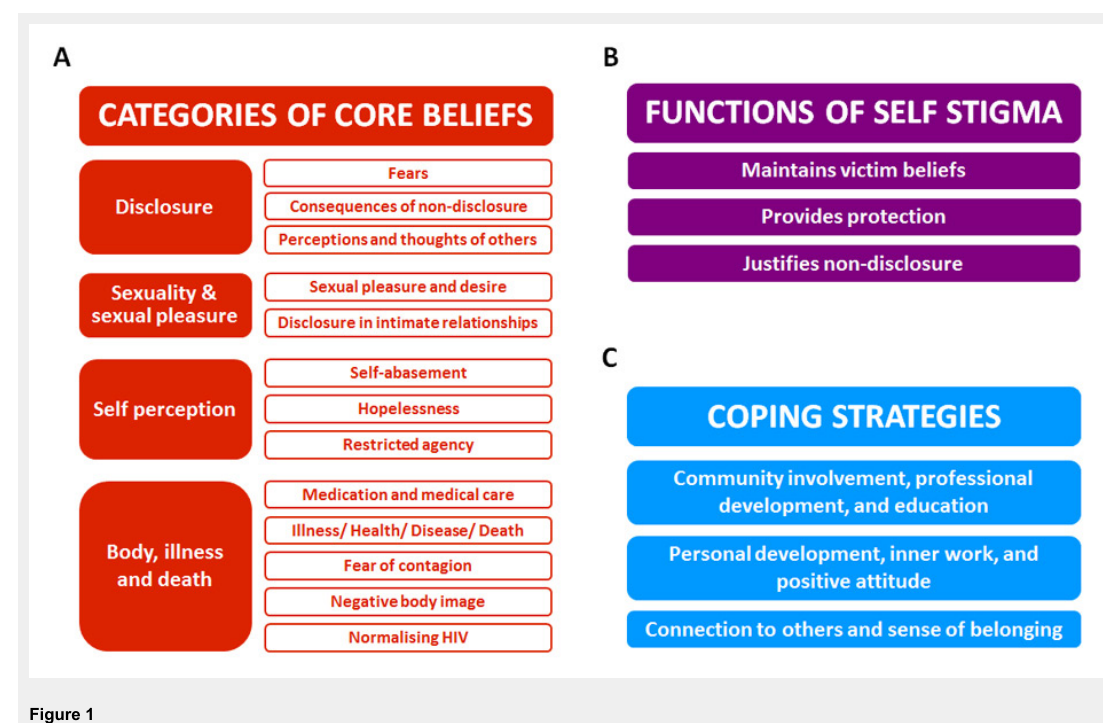
Framework for qualitative analysis of interview data. Three main areas of analysis are shown: Categories of core beliefs (A, red), Functions of self-stigma (B, magenta) and Coping strategies (C, blue). Emergent themes were organised into categories (solid boxes), and subcategories where required (open boxes).